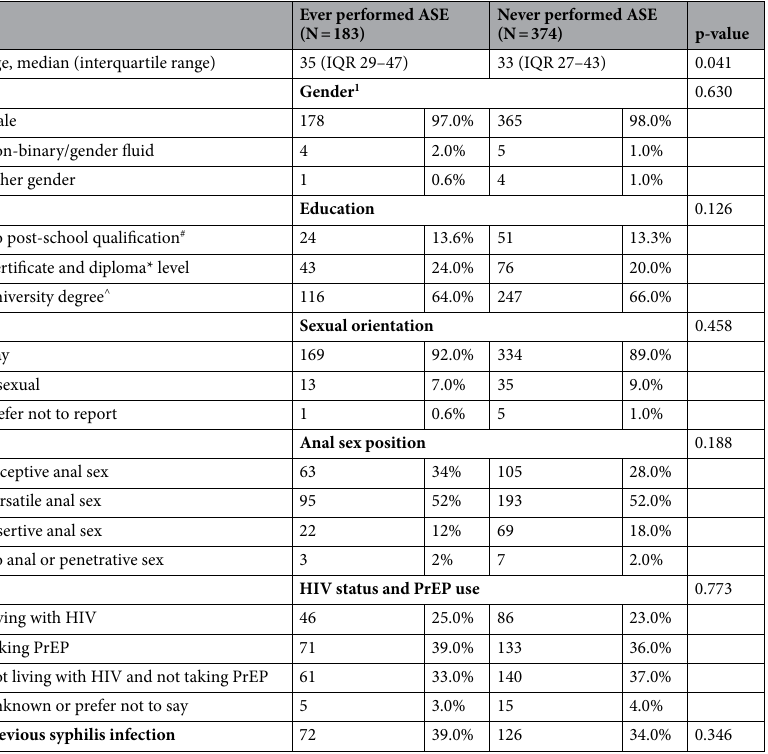
Table 1. Demographics of survey participants. 1 Female was not reported in the table as those identified